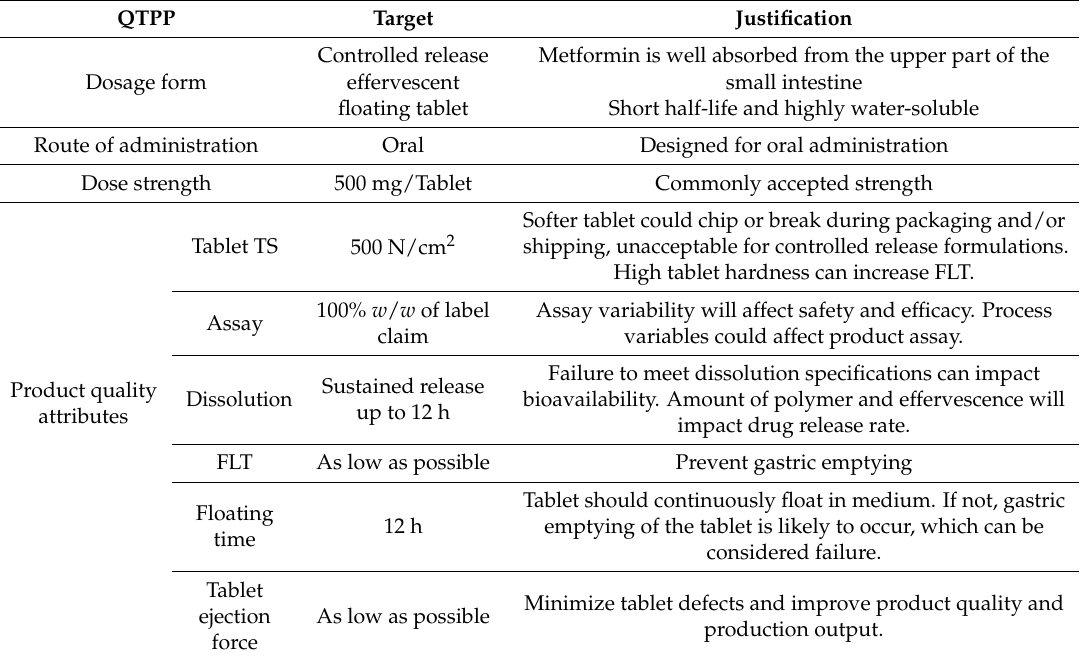
Table 2. Quality target product profiles (QTPP) of effervescent floating